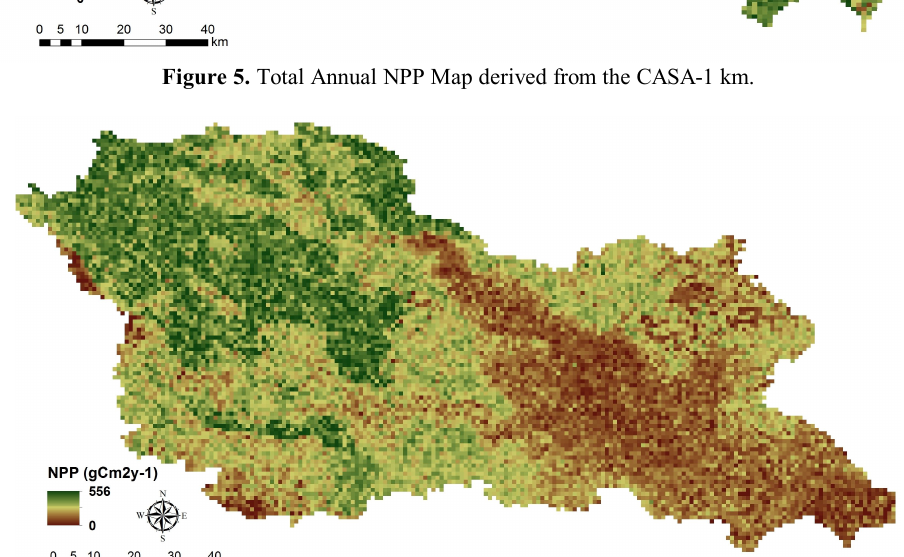
Figure 6. Total Annual NPP Map derived from the